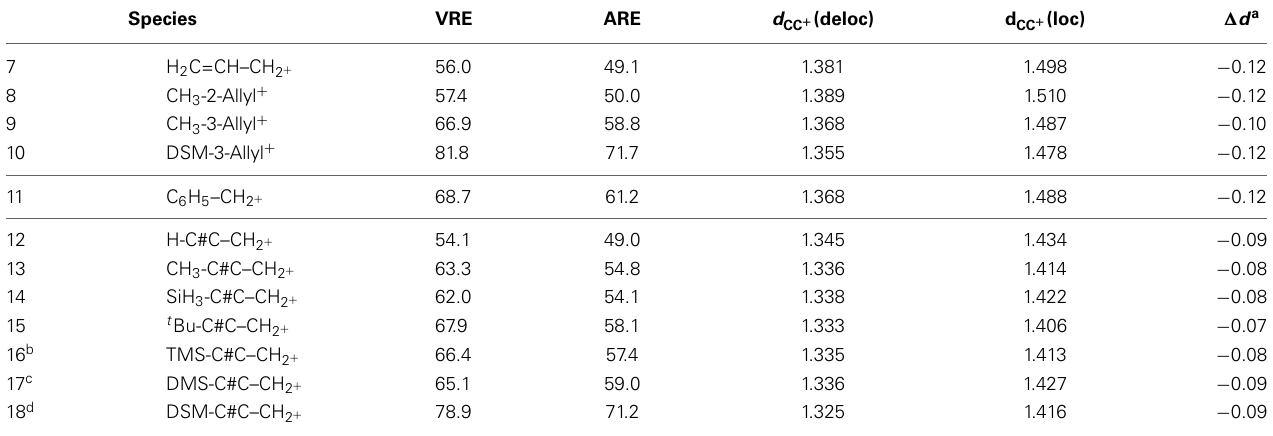
Table 3 | Vertical and adiabatic resonance energy (VRE and ARE) for the conjugated systems.